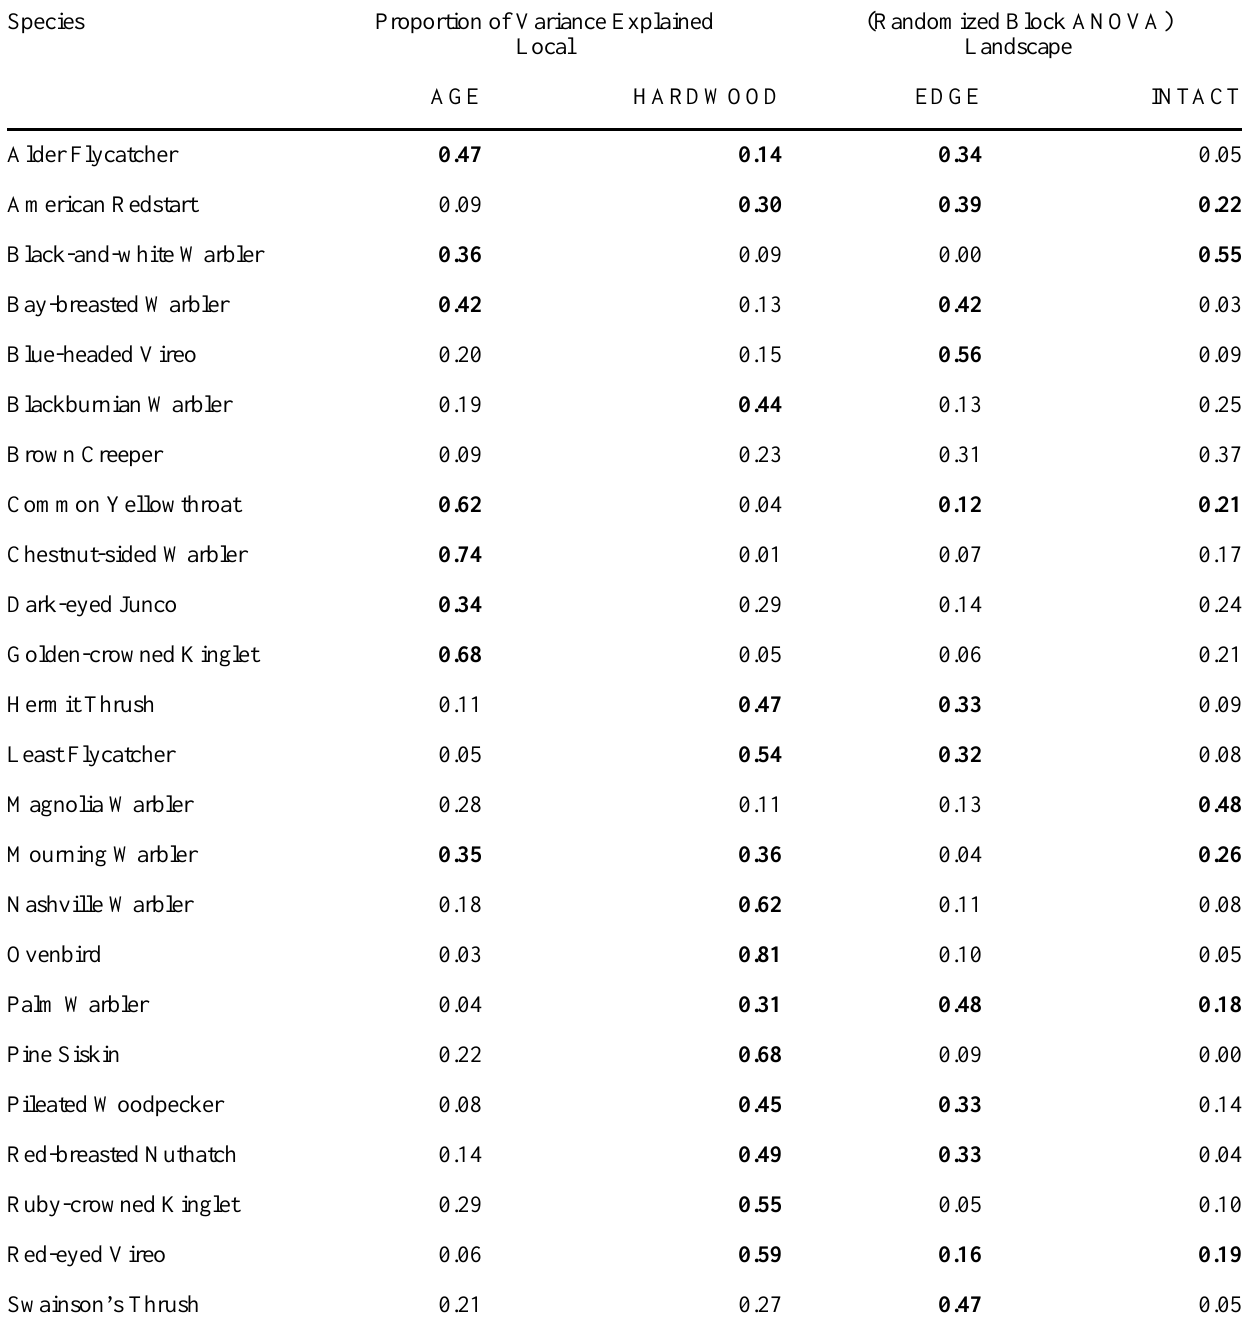
Table 5. Proportion of variance explained (PVE†) by the four environmental variables (ANOVA main- effects only). Variance components based on partial eta-square (PES) analysis. Significant (p < 0.05) effects are set in